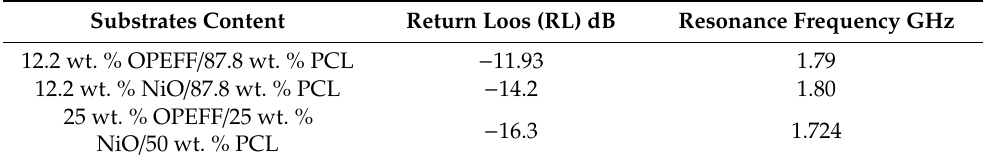
Figure 13. Antennas performance ( a ) 3-D Radiation pattern at 1.79 GHz for OPEFF / PCL, ( b ) 3-D Radiation pattern at 1.80 GHz for NiO / PCL, and ( c ) 3-D Radiation pattern at 1.724 GHz for NiO / OPEFF / PCL.